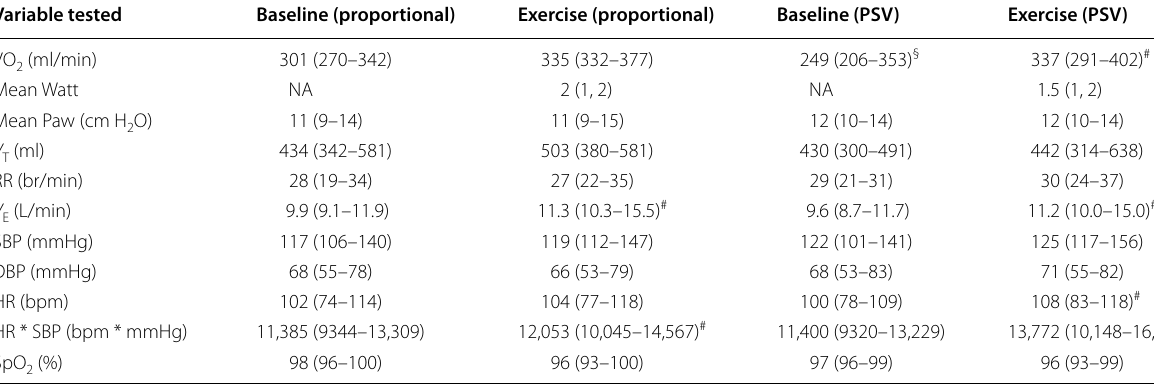
Table 2 Respiratory pattern and hemodynamic parameters